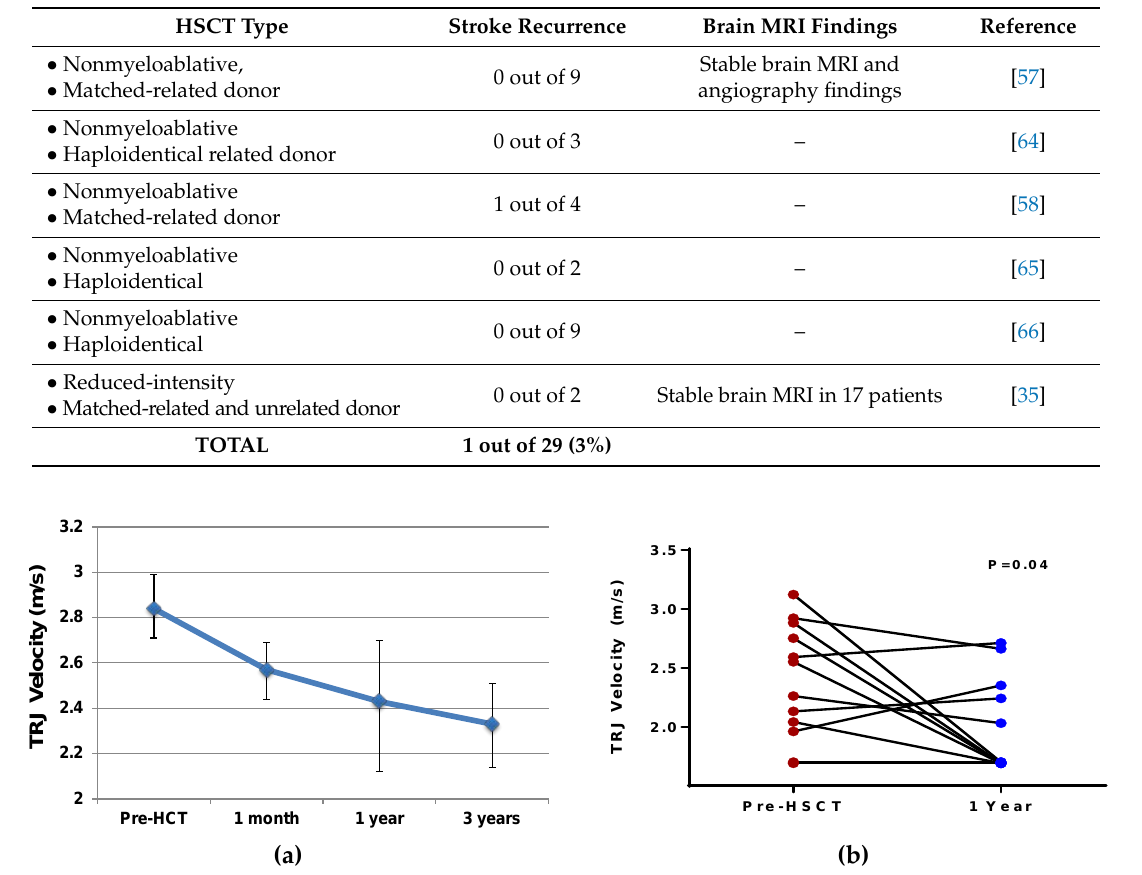
Table 5. Stroke recurrence and brain imaging findings in adults with sickle cell disease after allogeneic hematopoietic stem cell transplantation (HSCT).